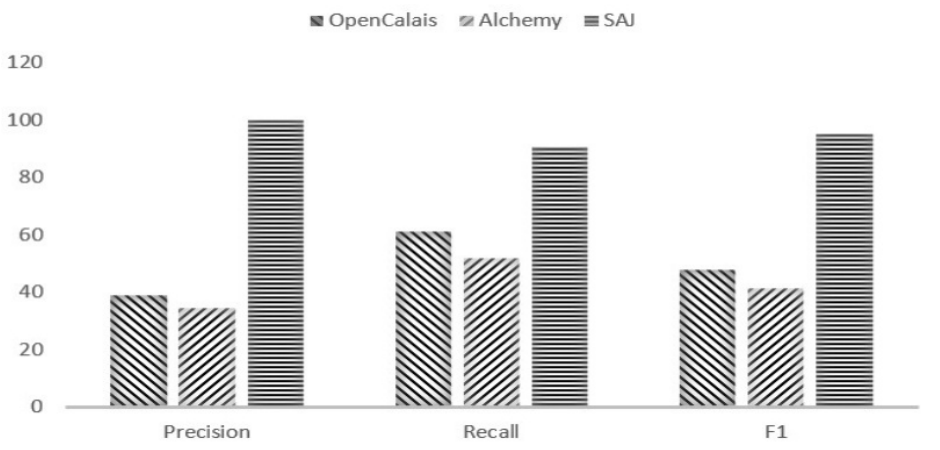
Figure 10. Comparative analysis among SAJ, Alchamy API and OpenCalais for Job